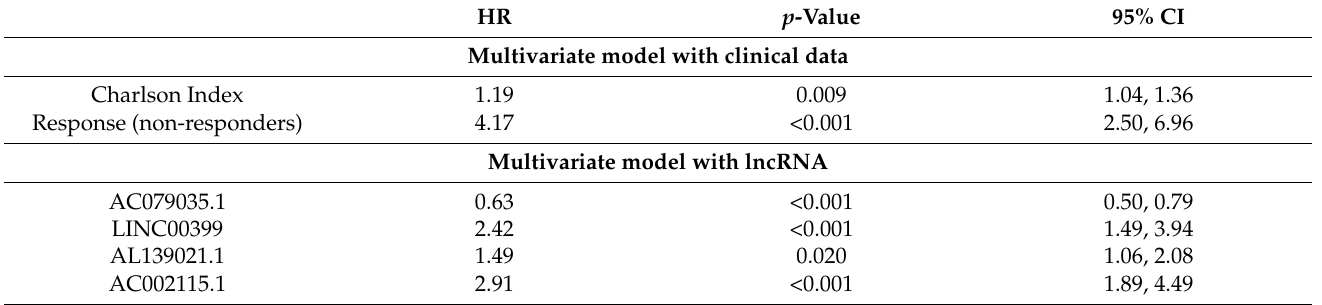
Table 2. Multivariate analysis of lncRNA with survival: The top of the table has clinical variables associated independently with survival in the multivariate analysis: only two of all variables significant in the univariable analysis of survival (variables in Table 1). Non-responders to initial chemotherapy have more than four-fold risk of dying from the disease. With each point increase of the Charlson co-morbidity Index, the risk of dying from disease is 19% higher. On the lower part of the table are those lncRNA associated independently with survival after the multivariate analysis.